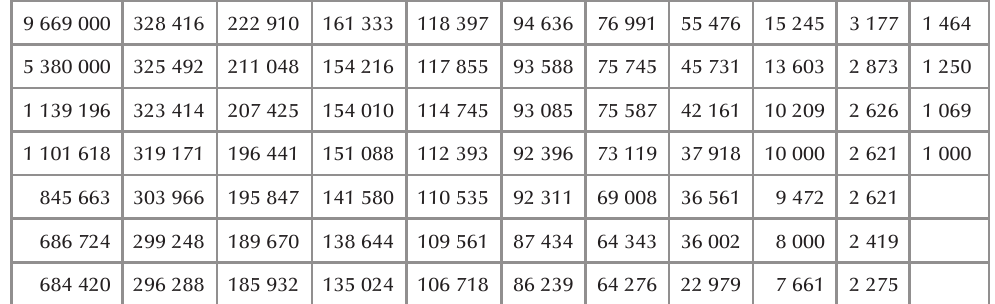
Operational loss data (in R) from a South African retail